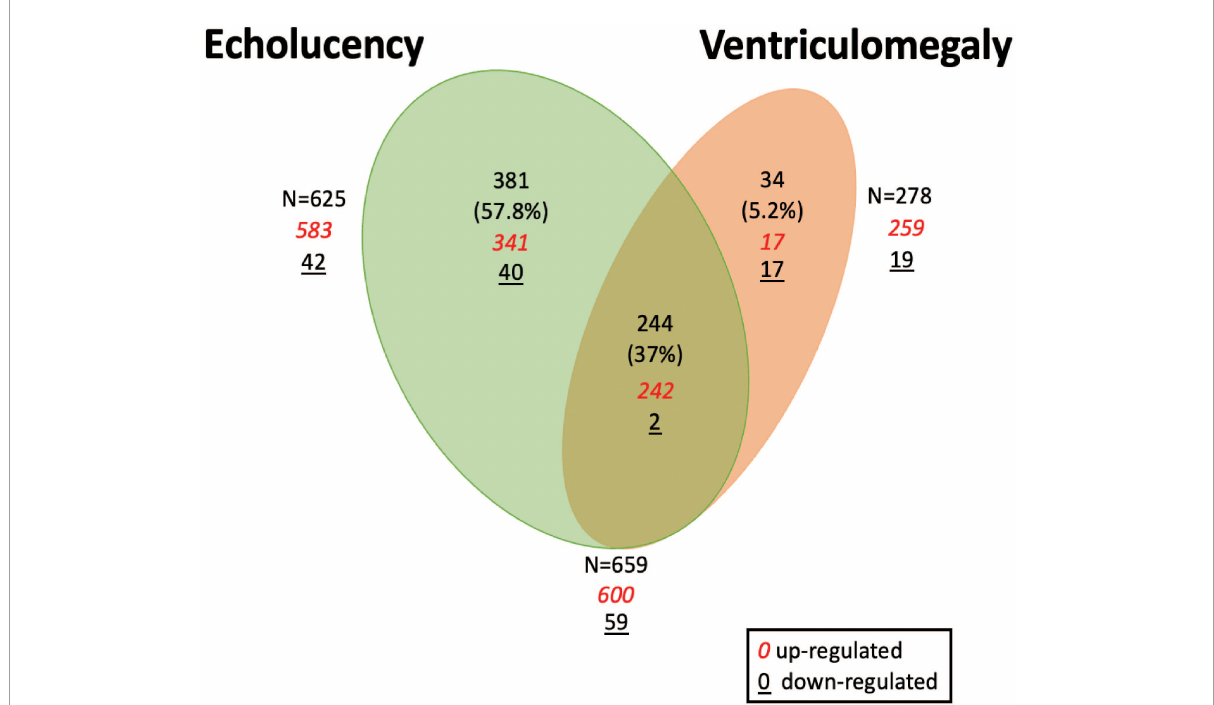
FIGURE1 Venn diagram of differentially expressed genes in the placenta in relation to cerebral white matter damage. Venn diagram demonstrating differentially expressed placenta genes in relation to echolucency, ventriculomegaly or both. A total of 625 genes displayed associations with echolucency, 278 genes displayed associations with ventriculomegaly, and 244 genes were displayed associations with both echolucency and